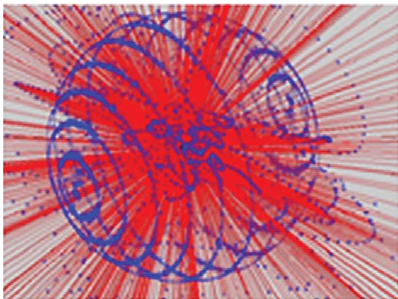
Fig. 5. Texture on the surface of the particle of the intersection between normal planes and their velocity vectors of the i th monodispersed mixture particle